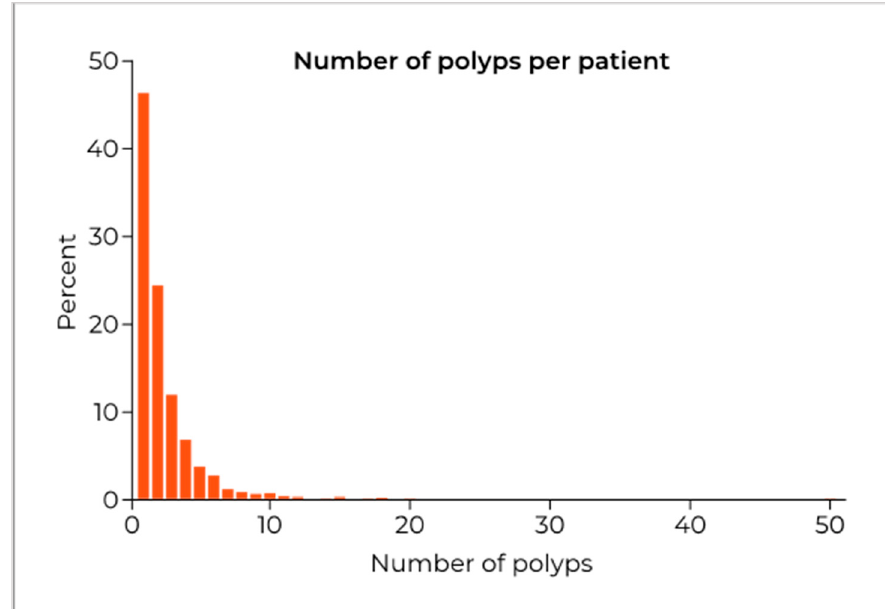
Figure 1. The distribution of the number of polyps per patient for the 1262 procedures that recorded the number of polyps in all segments with polyps detected.